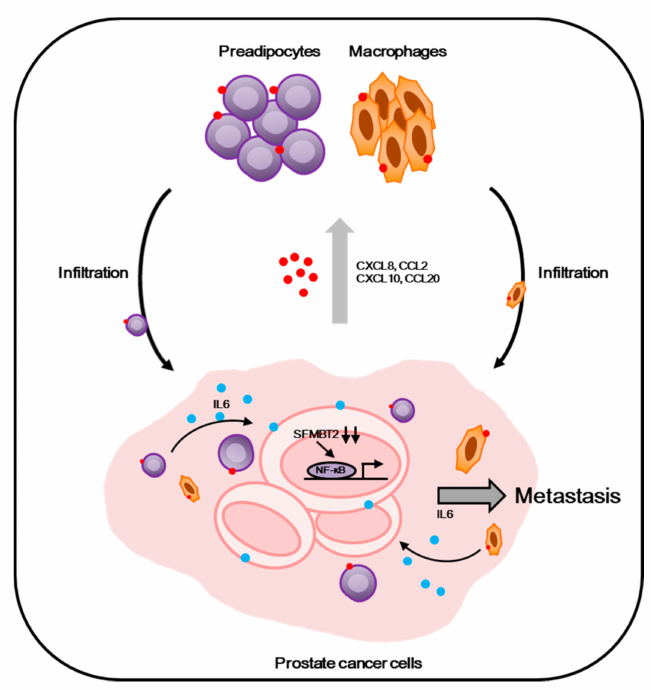
Figure 7. Proposed model. Prostate cancer cells expressing a low level of SFMBT2, which is correlated with a higher Gleason score ( ≥ 8), activate NF- κ B signaling and up-regulate the expression of chemokines such as CXCL8, CCL2, CXCL10, and CCL20. This event may promote the infiltration of preadipocytes and TAMs into the tumor microenvironment. In addition, IL-6 is up-regulated in infiltrated preadipocytes and TAMs, resulting in enhanced migration and invasion of prostate cancer cells for